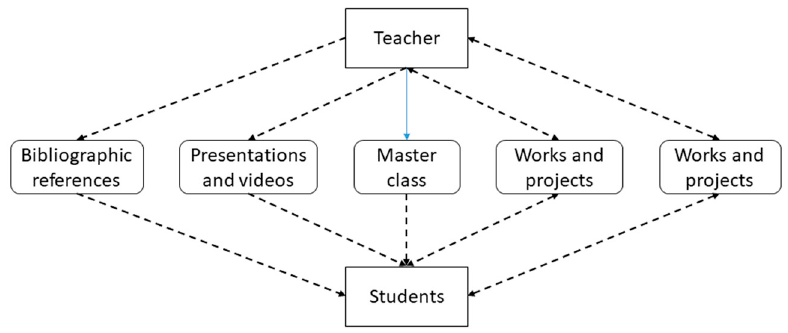
Figure 1. Face-to-face education model; education depends on the teacher.